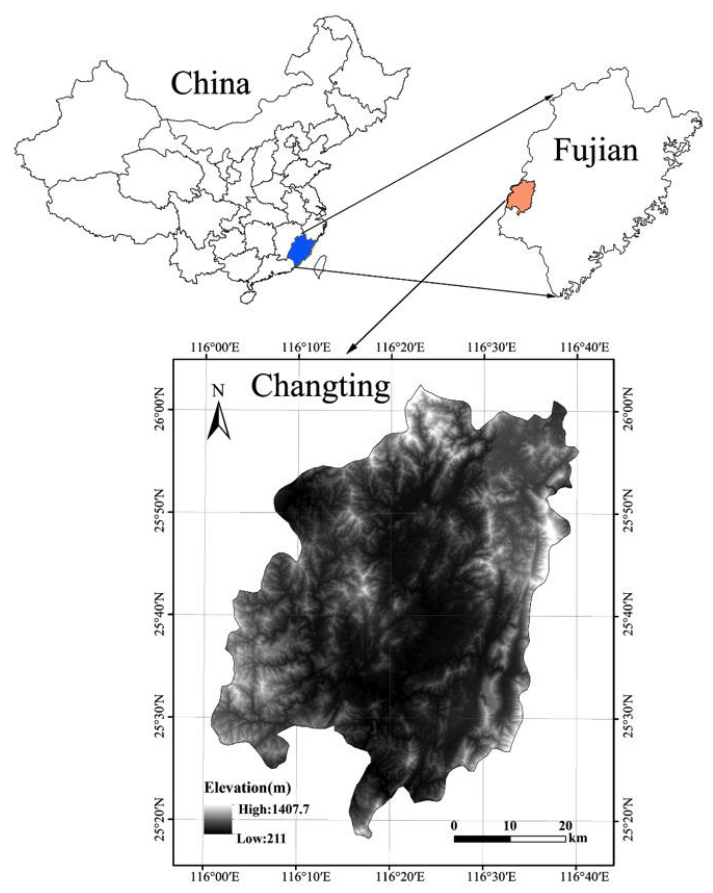
Figure 1. The location of the study.